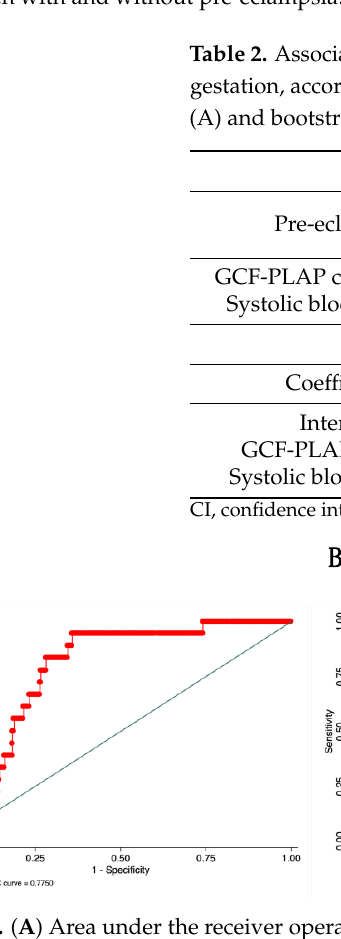
Figure 3. ( A ) Area under the receiver operating characteristic curve (AUC-ROC) of PLAP-GCF concentration and systolic blood pressure at 11–14 weeks of gestation versus the development of pre-eclampsia. ( B ) Area under the receiver operating characteristic curve (AUC-ROC) of the concentration of PLAP-GCF and systolic blood pressure versus the development of preterm pre-eclampsia. ( C ) Area under the receiver operating characteristic curve (AUC-ROC) of the concentration of PLAP-GCF and systolic blood pressure at 11–14 weeks gestation versus pre-eclampsia > 37 weeks of gestation. GCF, gingival crevicular fluid; PLAP, placental alkaline